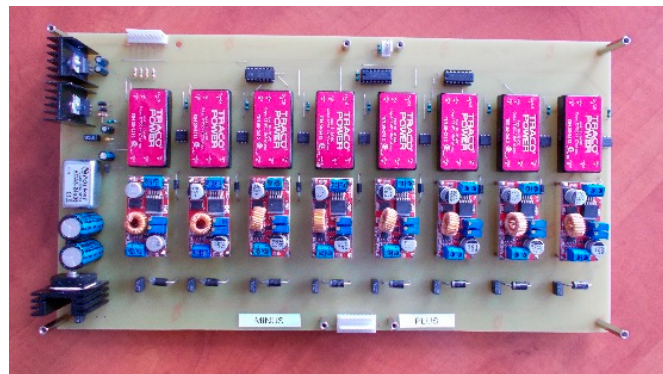
Figure 9. Active balancer module.